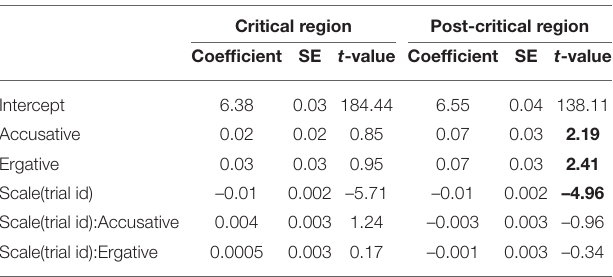
TABLE 10 | Lmer results for reading time at the critical (non-finite verb) and the post-critical region with trial id as a covariate for Experiment 3. The analysis uses treatment contrast, with the Locative condition as the baseline with the coefficient signifying the difference from the baseline.